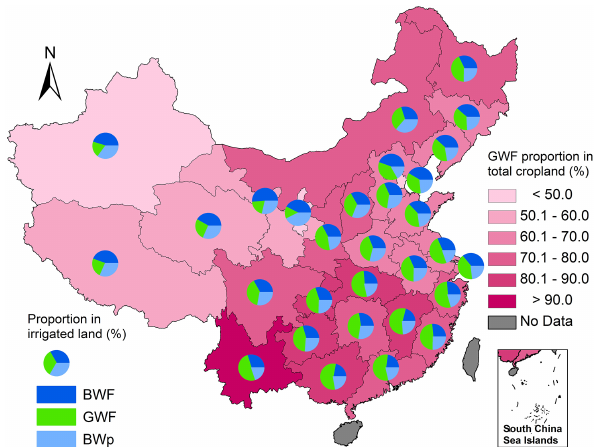
Figure 4. Proportion of GWF (green water footprint) in the total cropland and the composition of the TWU (total water use) in the irrigated land in